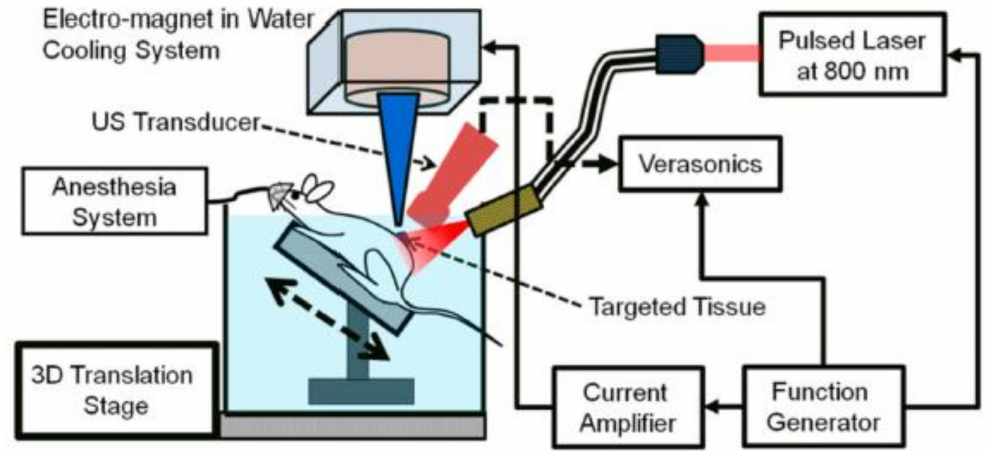
Figure 20. Schematic of the in vivo magneto-photo-acoustic imaging system. Adapted with permis- sion from [158], Copyright 2015, American Chemical